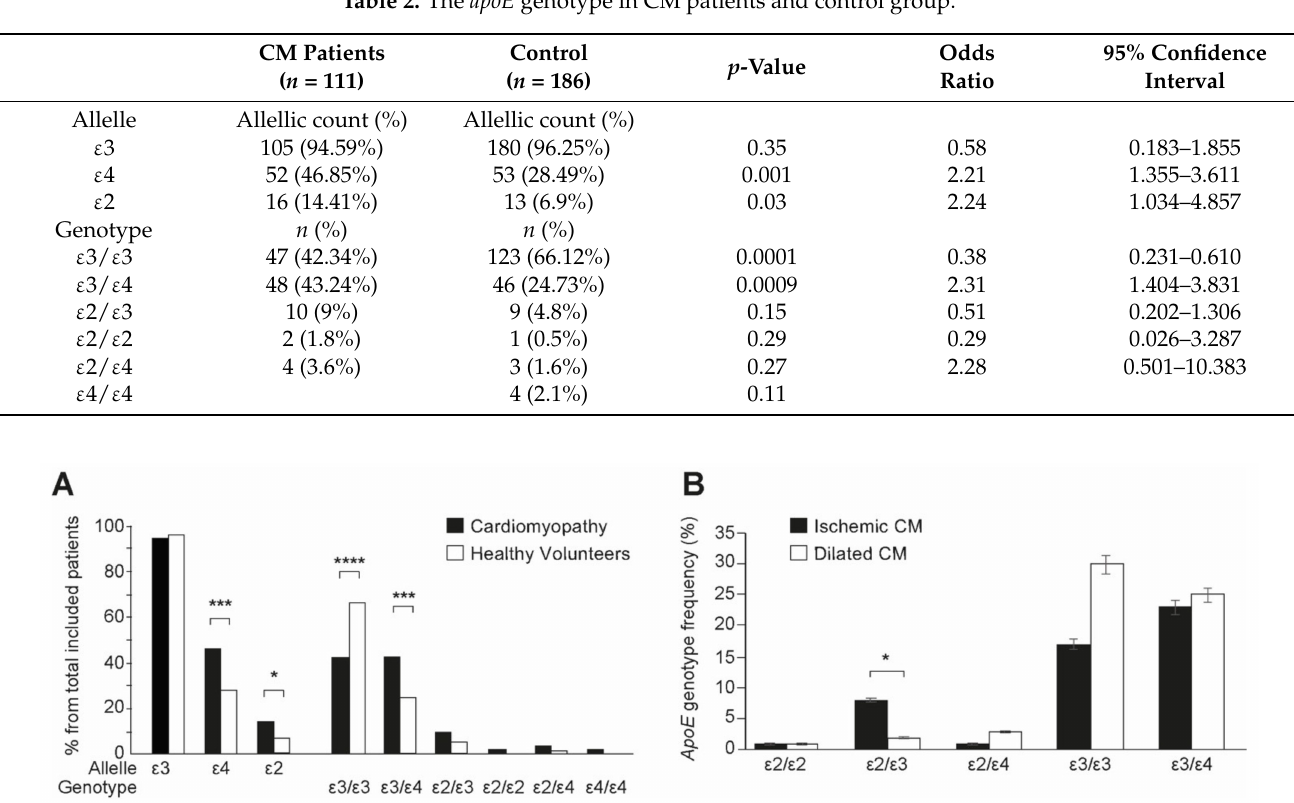
Figure 6. Genotype frequency and allele frequency between the groups. ( A ) Patients with cardiomyopathy (black columns) present ε 2 and ε 4 alleles more frequently as compared with controls (white columns). ( B ) The distribution of different alleles was not dependent on ischemic (black columns) or non-ischemic (white columns) etiology of cardiomyopathy